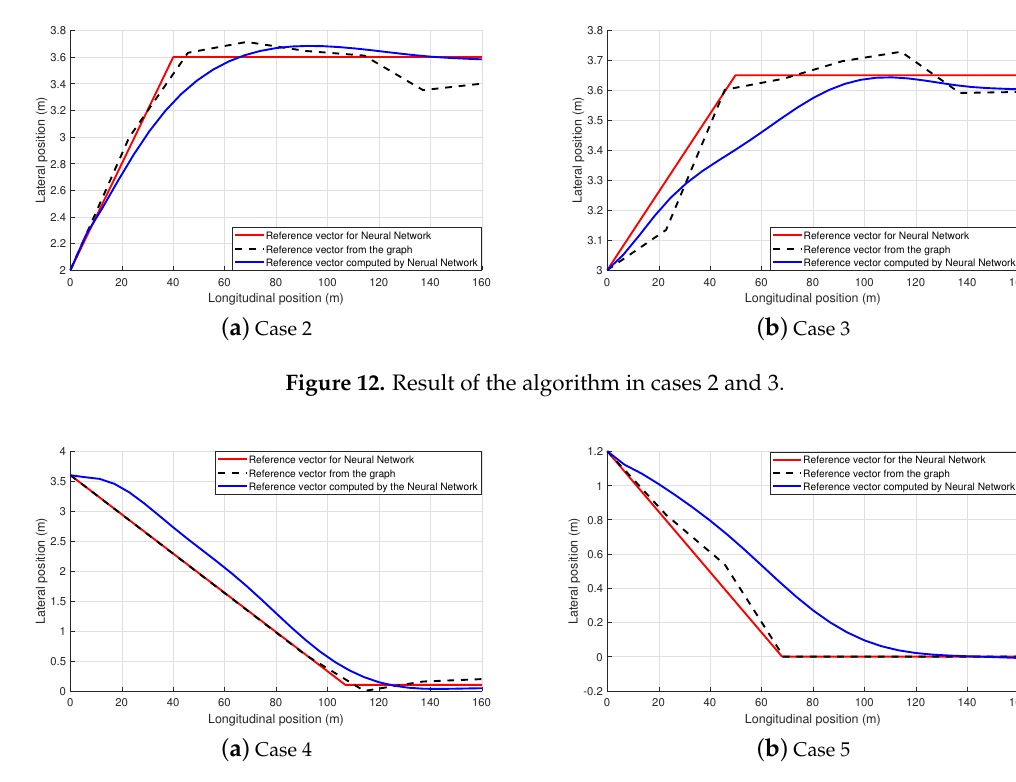
Figure 13. Result of the algorithm in cases 4 and 5.